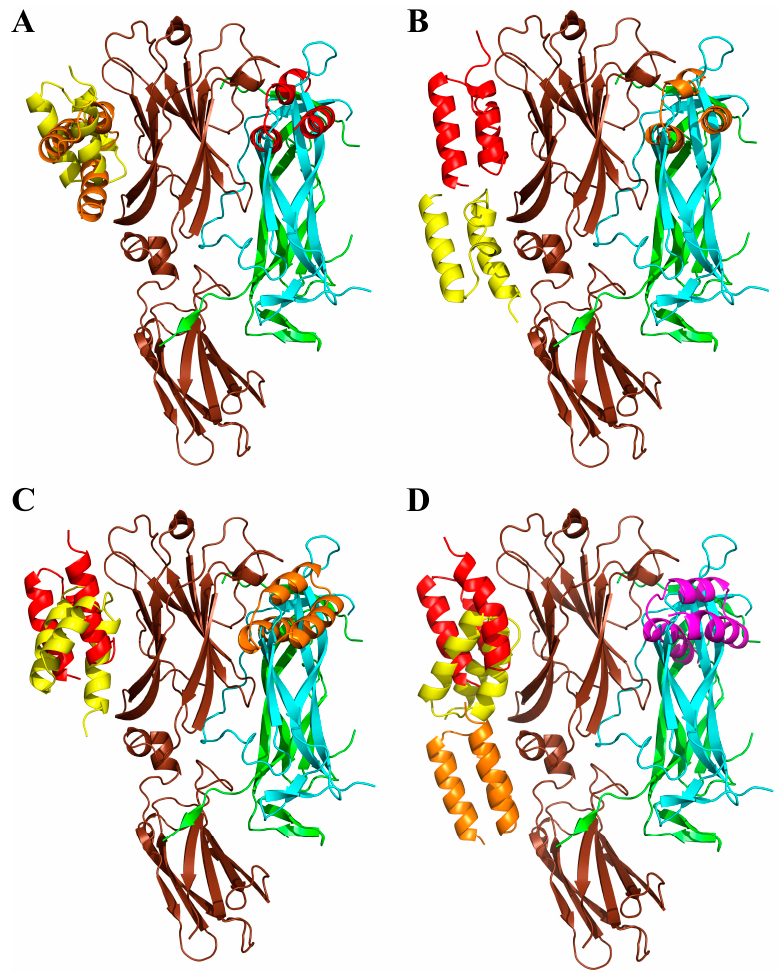
Figure 8. Modeling of ARS/IL-17RA interactions by docking. Summary of the first three poses of the ARS004 ( A ), ARS012 ( B ), ARS019 ( C ), and four poses of the ARS043 ( D ) binding to the complex of IL-17RA (brown) and dimer of human IL-17A (green/cyan), in decreasing predicted order of probability demonstrated in red (the most probable), orange, yellow and magenta, respectively.